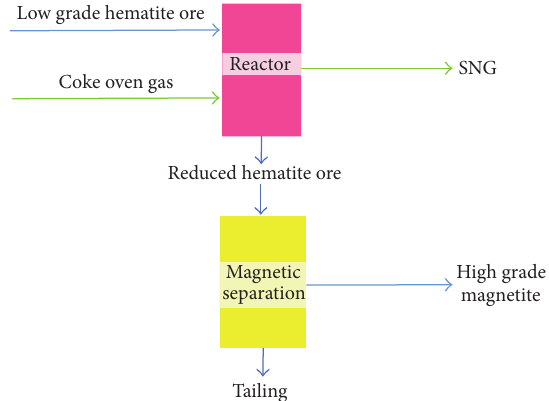
Figure 1: The schematic diagram of use for the low grade hematite ore and the surplus coke oven gas to produce SNGs and high grade